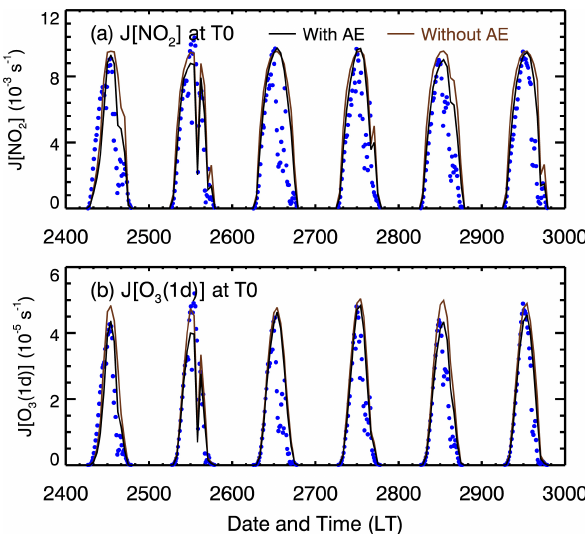
Figure 7 Fig. 7. Diurnal variations of photolysis frequencies of J [O 3 ( 1 D)] and J [NO 2 ] at T0 during the period from 24 to 29 March 2006. Blue dots: measurements; black line: with the aerosol effect on photolysis frequencies; brown line: without the aerosol effect on photolysis frequencies. See Fig. 2 for the x-axis labels.